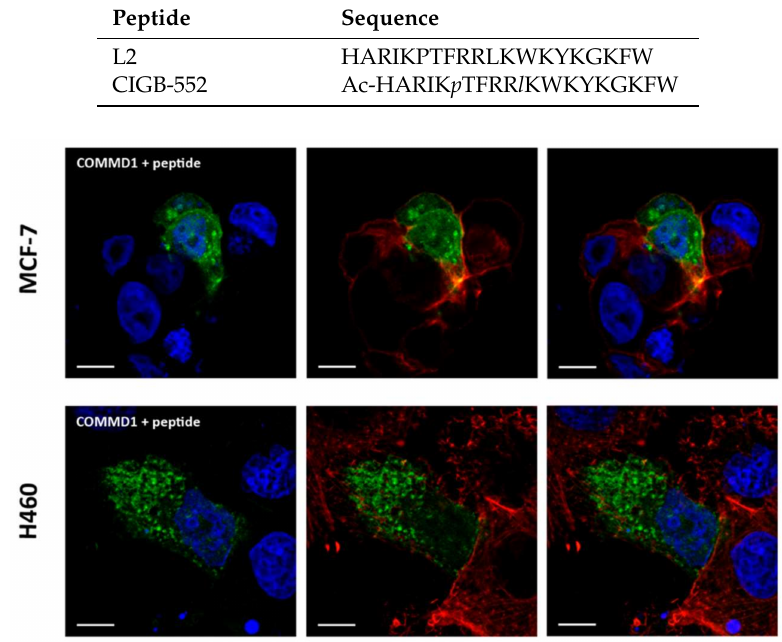
Figure 8. Protein complementation assays were performed between the peptide and COMMD1 protein. MCF-7 and H460 cell lines were co-transfected and 24 h later, in situ interaction was evaluated by confocal microcopy. Both cell lines show the interaction between the peptide and its target protein, resulting in Venus protein expression (green). Nuclei were labelled using TOPRO-3 probe (blue) and actin cytoskeleton was labelled with phalloidin (red) (scale bar = 10 µ